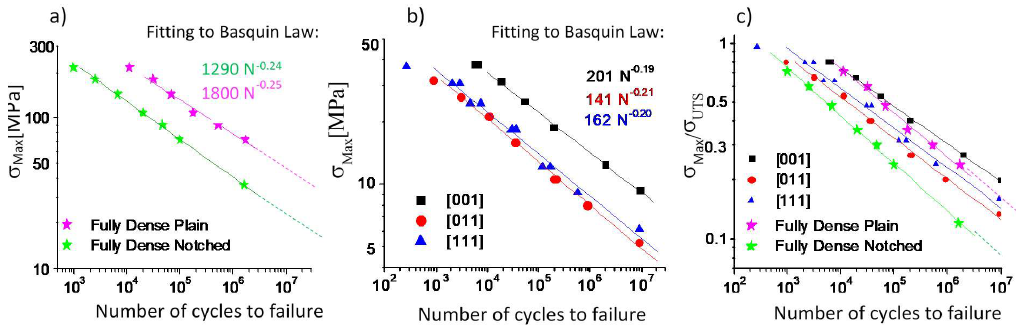
Figure 17. Fatigue lives as functions of maximum stress of the ( a ) plain/notched dense specimens and ( b ) lattice specimens; ( c ) fatigue lives of dense and lattice specimens as function of the maximum stress normalized with σ UTS .